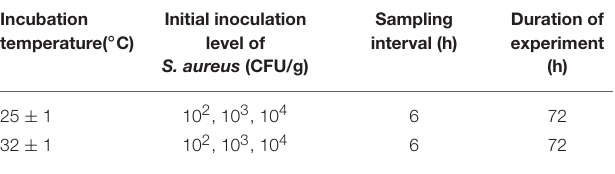
TABLE 2 | Additional experiment groups designed for validating the predicted model. Incubation temperature( ◦ C)